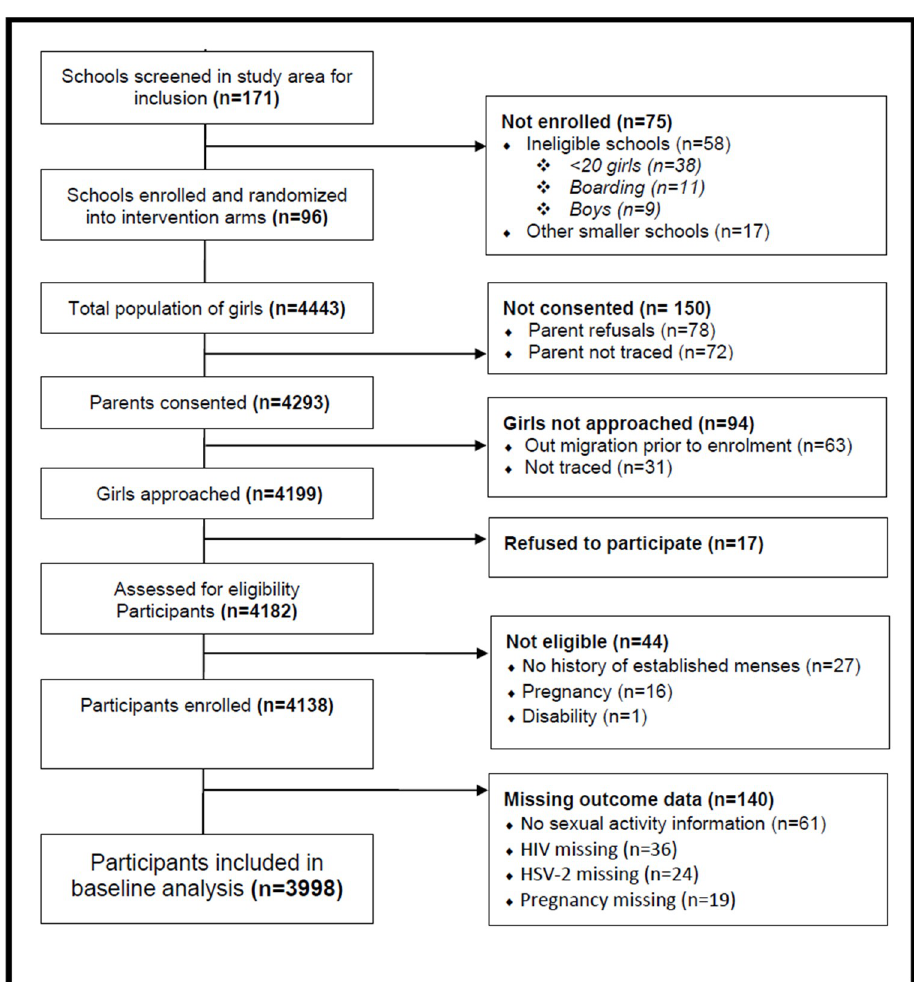
Fig 1. Flow diagram of CCG Trial participant